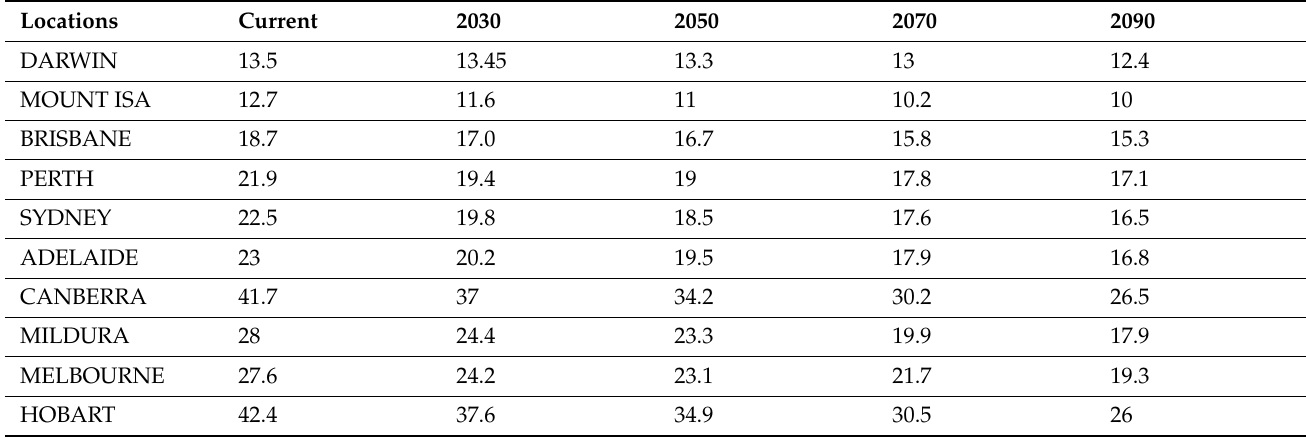
Table 11. Large hospital’s yearly boiler heating energy needs in kWh/m 2 .